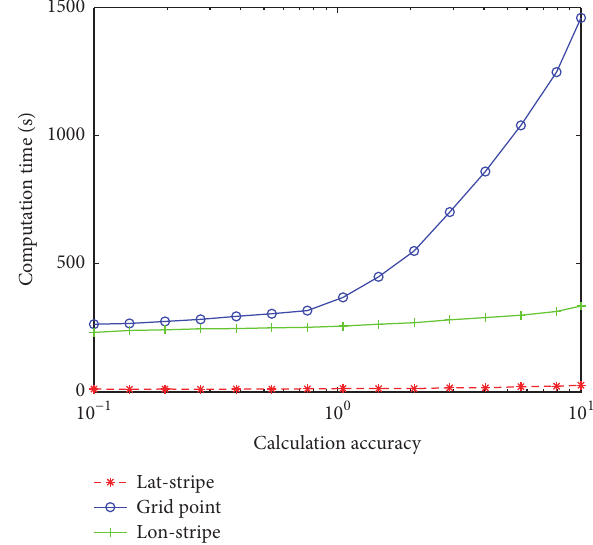
Figure 10: Calculation time varies with the calculation accuracy by three